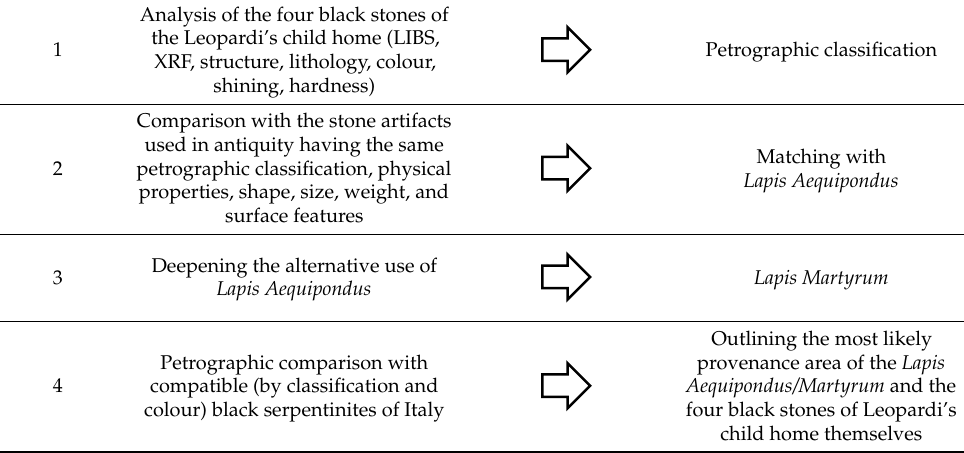
Figure 1. The four black stones. Two with the same weight of 16.9 kg ( 1 , 4 ) and two smaller ones ( 2 , 3 ) of 5.6 kg each. The red arrows indicate the traces of partially smoothed grooves originally used to fix a harness or a ring and the relative hook (or a grappling hook). The graphic scale is 10 cm (the small black and white squares in the right part are 1 cm 2 each). ©Famiglia Leopardi Recanati. Courtesy of Leopardi family, any reproduction is forbidden. Table 1. Methods and rationale of the present study (in four phases) aimed at unraveling the origin of the investigated black stones of Leopardi’s child home.